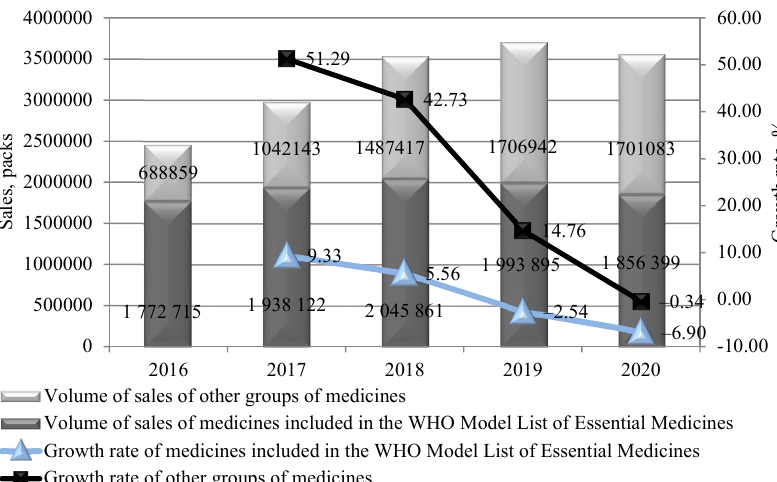
Fig. 7. Dynamics of indicators of sales volumes in physical terms of drugs included in the WHO Model List of Essential Medicines and other medicines for the pharmaceutical market of